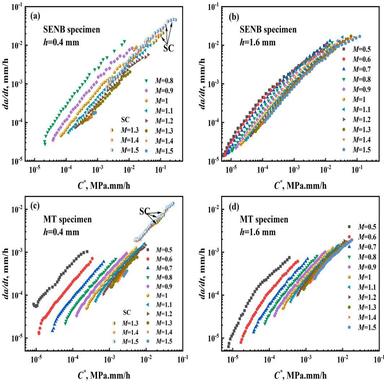
The da/dt-C\ curves at different mismatch factors for (a) SENB specimens under h = 0.4 mm, (b) SENB specimens under h = 1.6 mm, (c) MT specimens under h = 0.4 mm and (d) MT specimens under h = 1.6 mm.